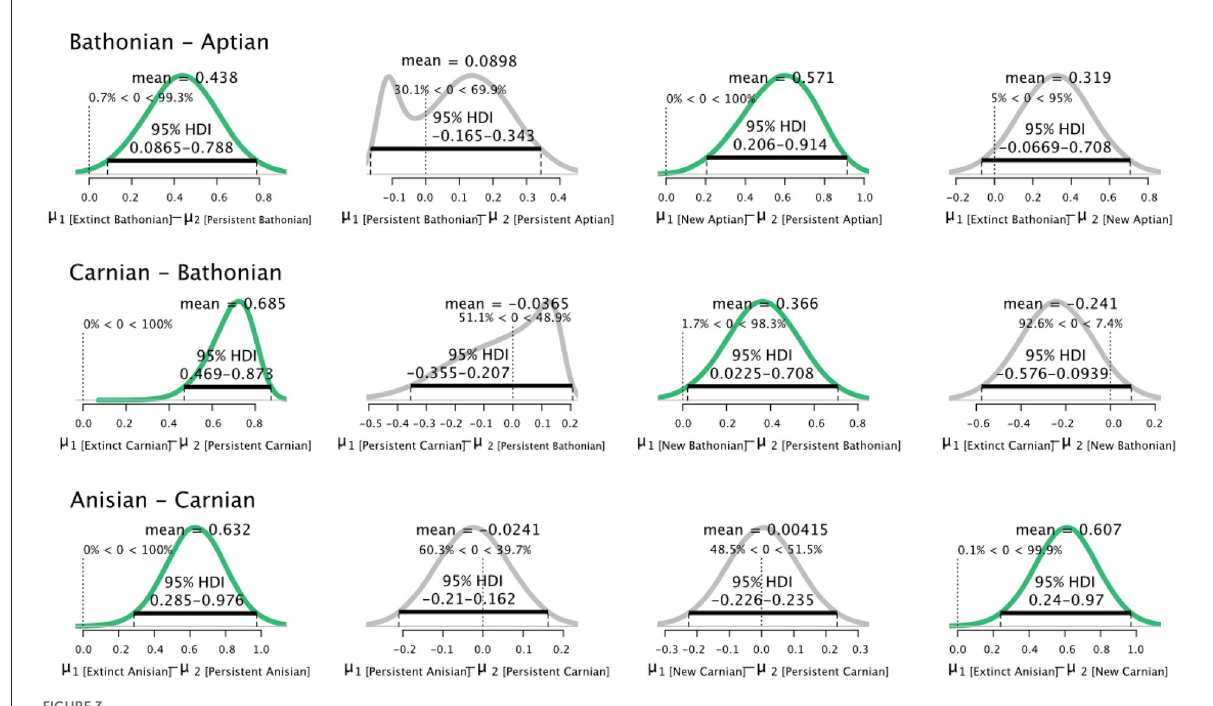
FIGURE3 Differences in posterior distributions of ntp for guilds that were extinct, persisted, or were new between sequential pairs of communities. Bathonian–Aptian (top) , Carnian–Bathonian (middle) , Anisian–Carnian (bottom) . The mean is shown for each resulting distribution, as is the 95% High Density Interval (black bar). Finally, the percentage of data that falls below and above zero is shown on the small vertical dotted